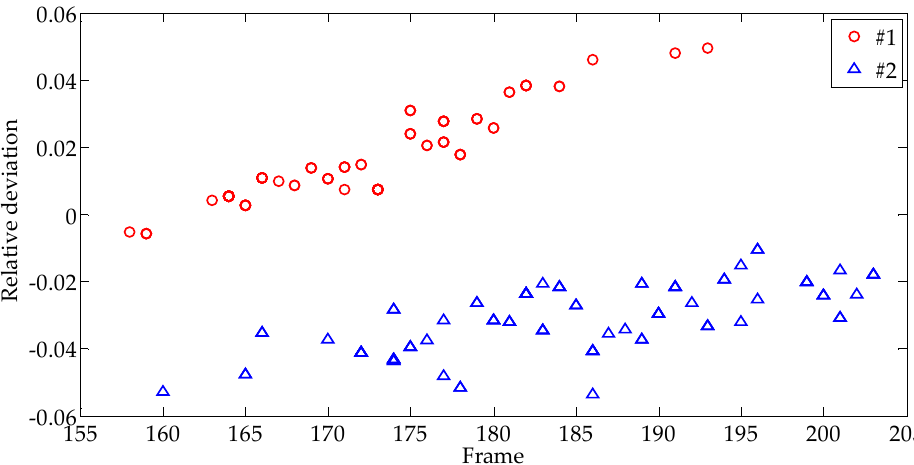
Figure 17. Discrete distribution of relative deviation of defect area for 100 times primary detection.